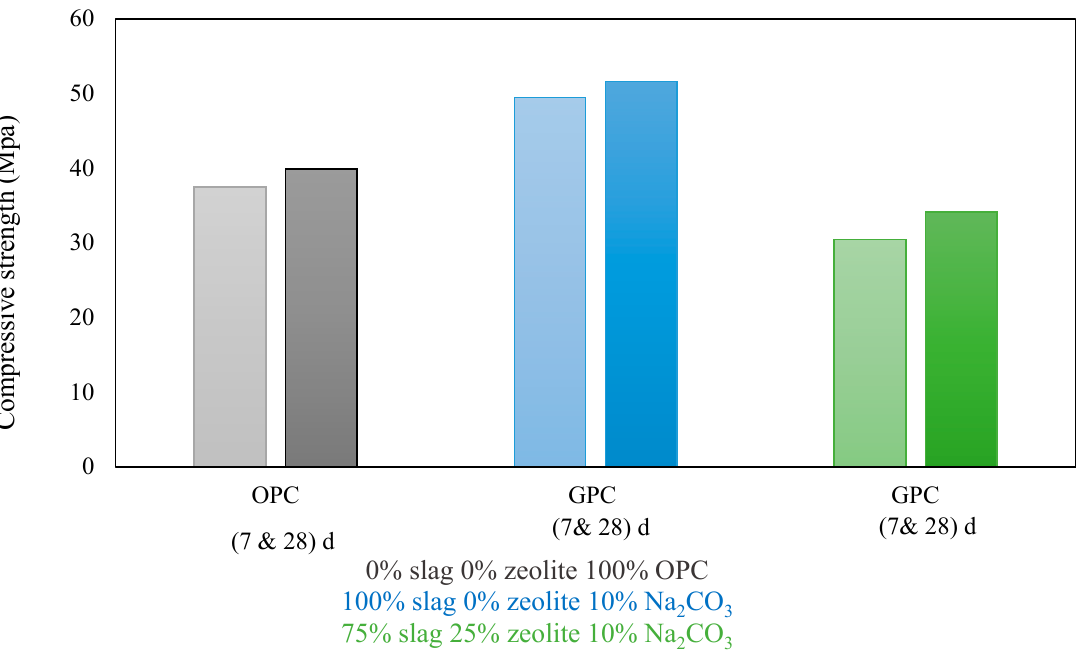
Figure 17. GPC and Portland cement concrete (PCC) compressive strength experiment data (10% Na 2 CO 3 by weight of powder mixtures (slag and zeolite), 50% fine aggregate) [45].